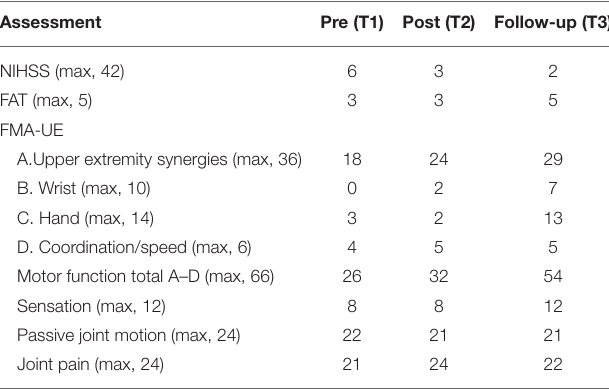
TABLE 1 | Assessments from the stroke participant [NIHSS, FAT, and FMA-UE at pre- (T1) and post-intervention (T2) and at follow-up (T3)].